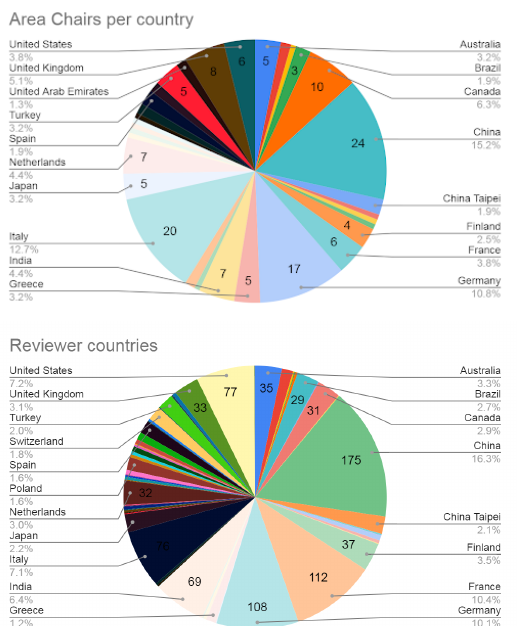
Figure 3. Area Chairs and reviewers per country.